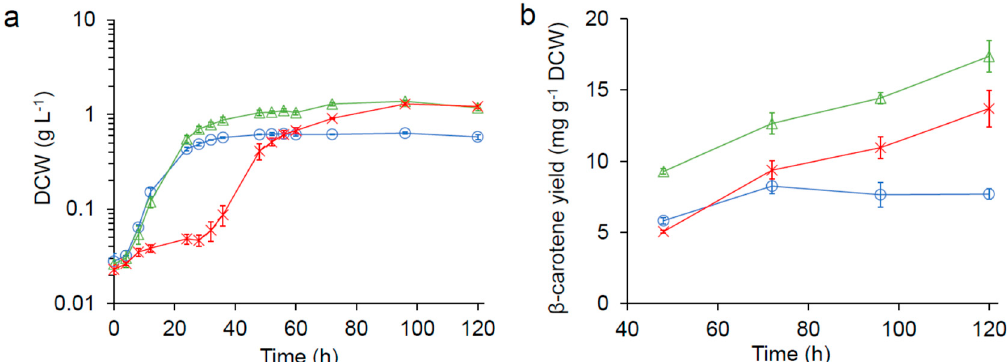
Figure 1. Growth kinetics of SM14 in 0.1× yeast nitrogen base (YNB) media (20 mL) made with freshwater ( ), 1/3× seawater ( ), and seawater ( ) in 125 mL flasks. ( a ) growth kinetics (DCW: dry cell weight). ( b ) β -carotene production.